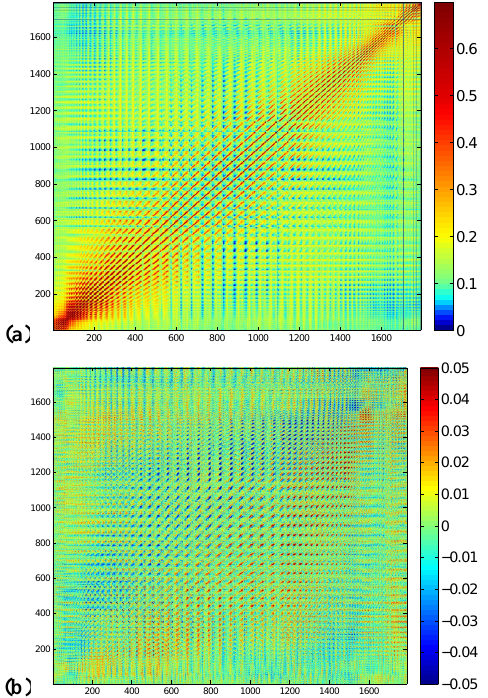
Fig. 4. (a) It is the matrix of Q for α =94%, (b) matrix for q for α